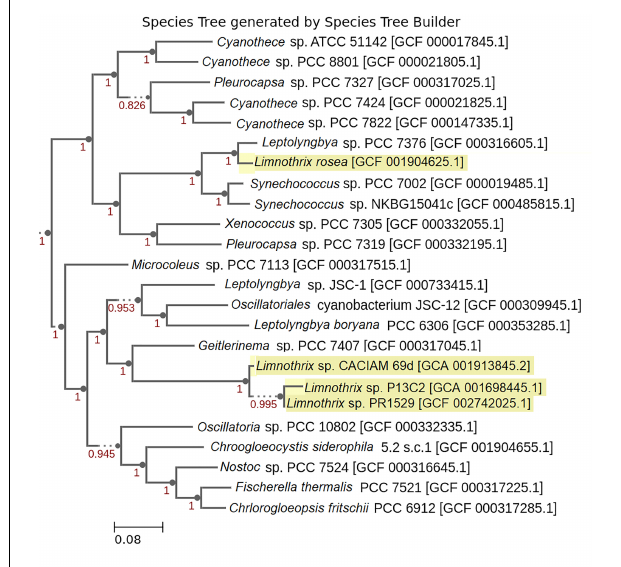
The taxonomic rank is shown for each bin, including estimated completeness, contamination and coverage.